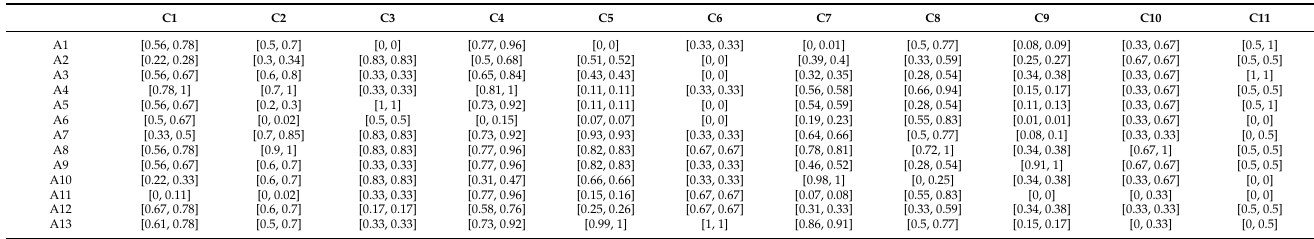
Table 7. Normalized matrix.